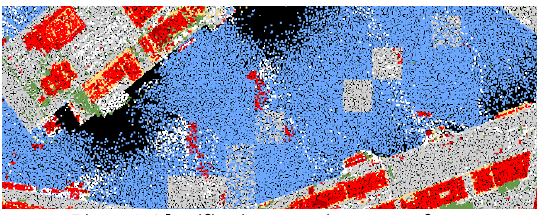
Figure 4. Classification errors in water surfaces.